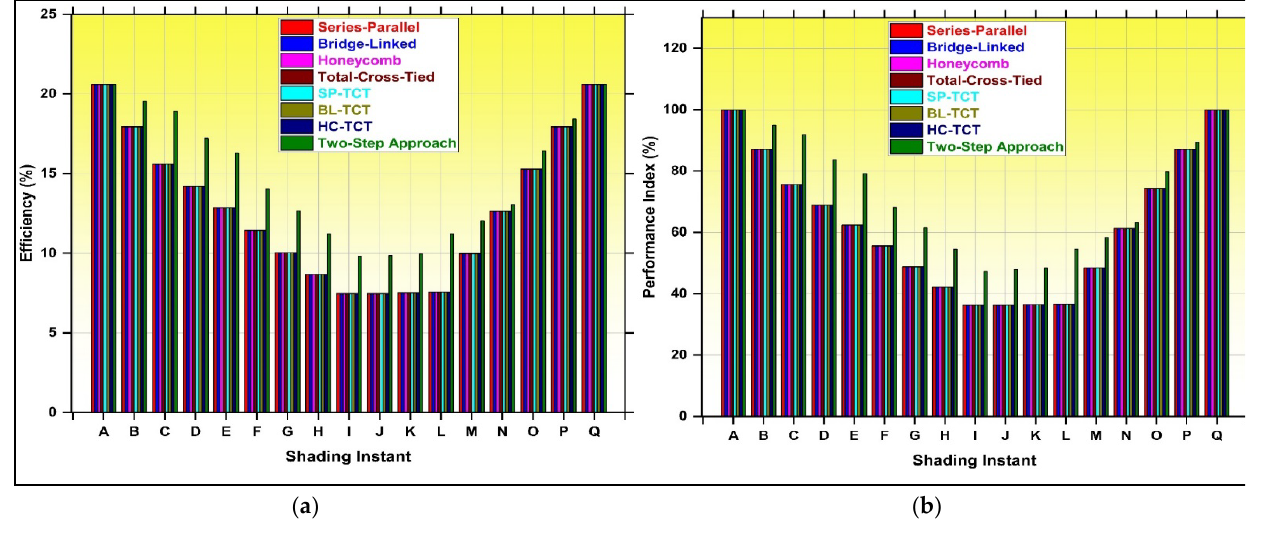
Figure 21. Comparison of ( a ) efficiency and ( b ) performance index of the 8 × 3 configurations using the proposed two-step approach for partial shading cases.